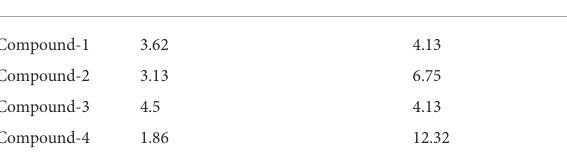
TABLE 7 IC50 value of HSP90 inhibitors on human cancer cell